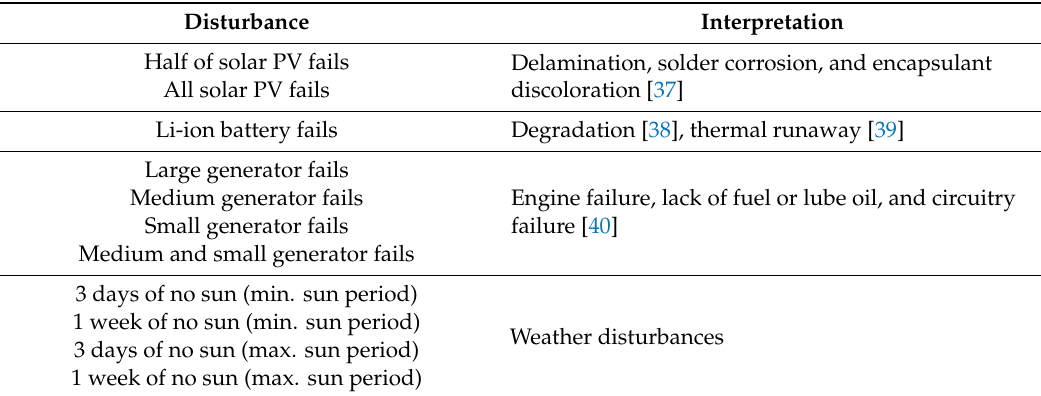
Table 5. Summary of interconnection scheme of the four-island